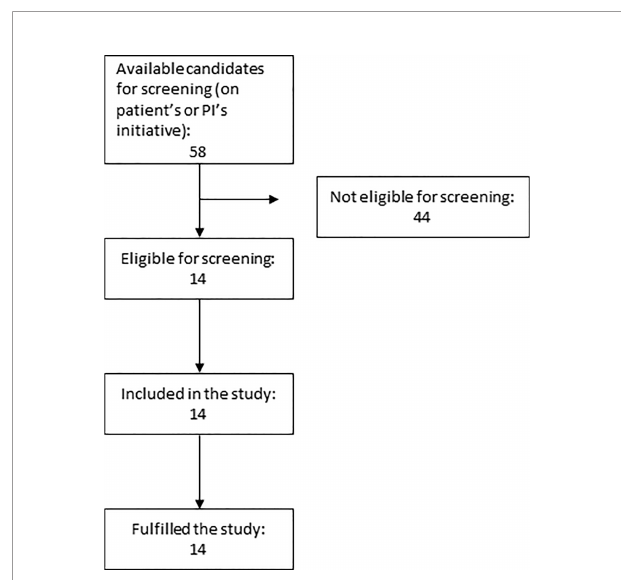
FIGURE 1 | Flow Chart showing the number of patients approached, eligible and later included in the